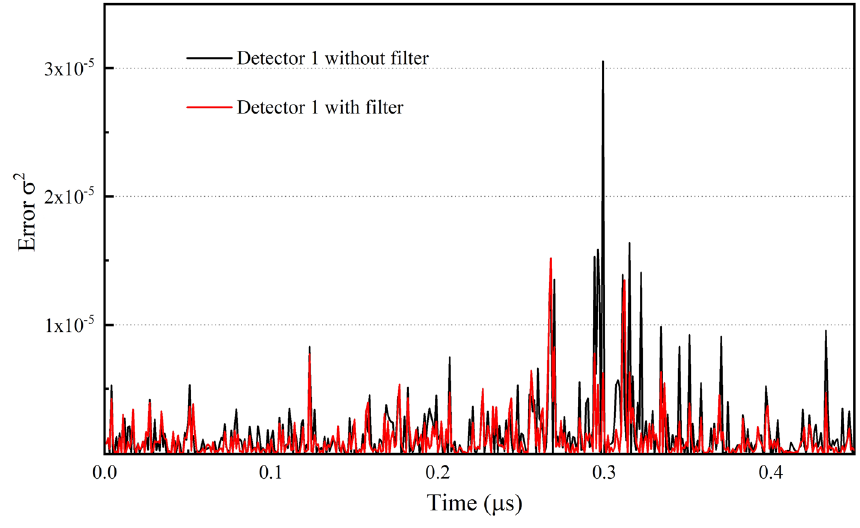
Figure 5. Phase variation characteristics of a random signal with and without Kalman filtering.